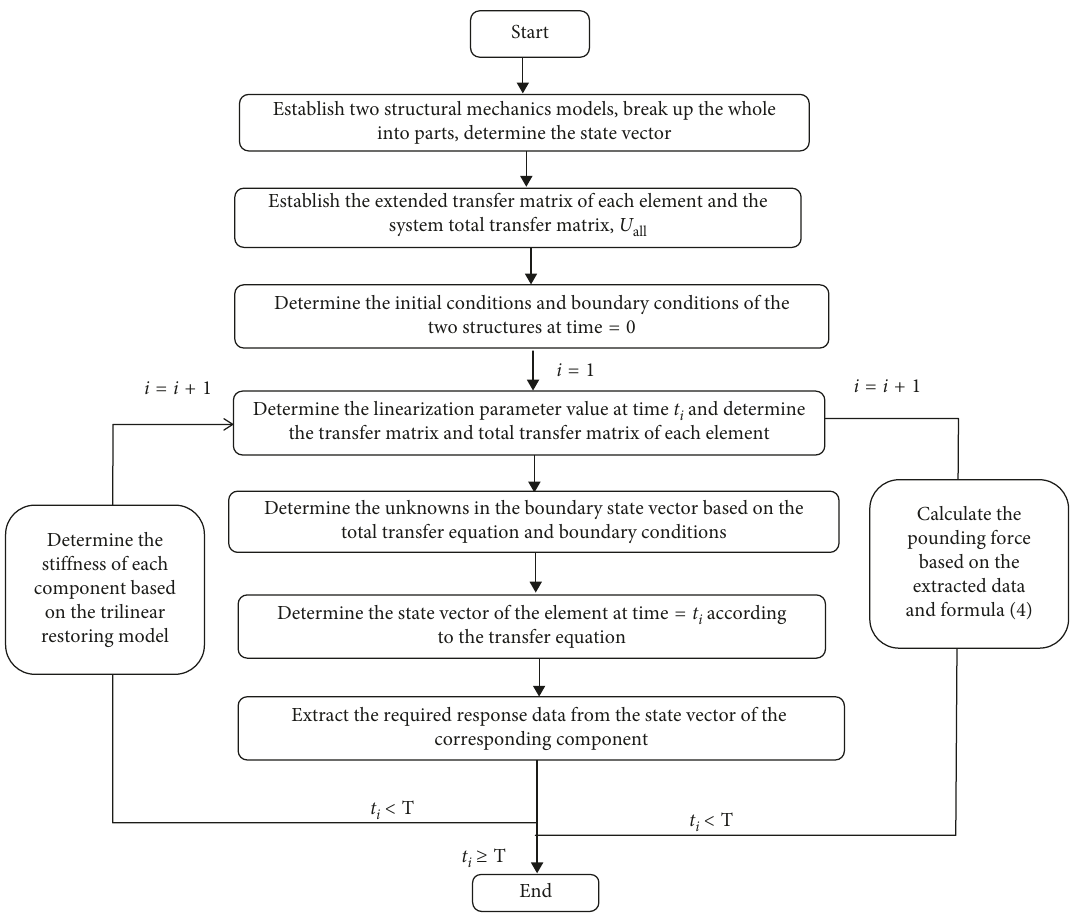
Figure 9: The process for calculation of pounding response based on MS-TMM. Table 2: Seismic wave peak acceleration peak and separation gap size description